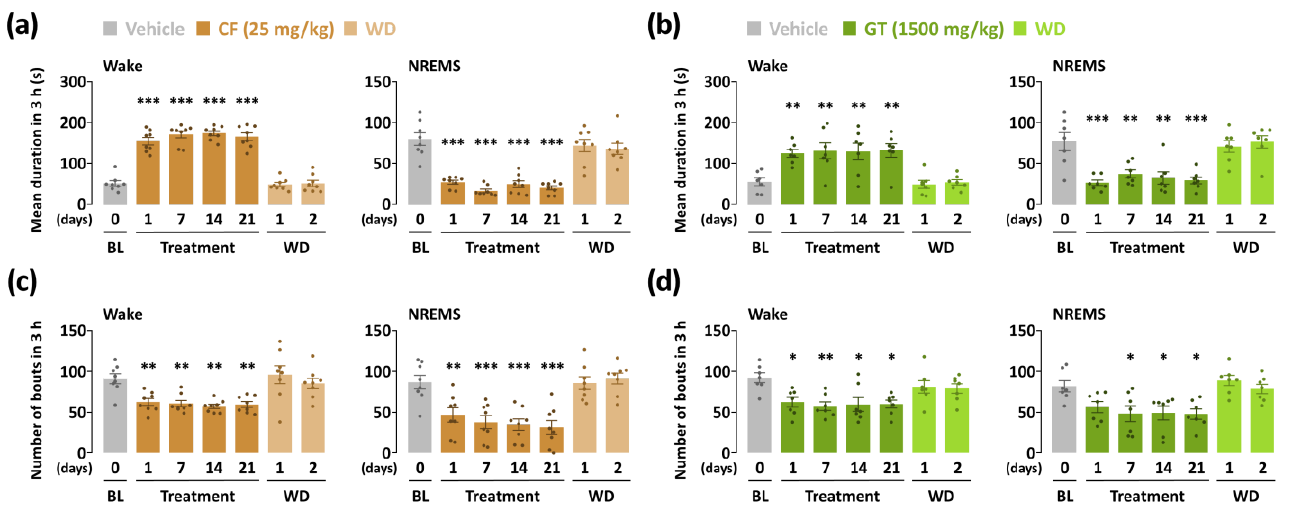
Figure 5. Features of sleep–wake bouts during the 3 h following sample treatment for the chronic administration period (21 days). ( a ) Changes in mean duration of wakefulness and NREMS after caffeine (25 mg/kg) treatment. ( b ) Changes in mean duration of wakefulness and NREMS after GT (1500 mg/kg) treatment. ( c ) The number of bouts of wakefulness and NREMS after caffeine treatment. ( d ) The number of bouts of wakefulness and NREMS after GT treatment. Grey bars illustrate the baseline day (vehicle). Brown and green bars illustrate days when caffeine and GT treatment were administered, respectively. Light brown and green bars illustrate withdrawal (WD) days after caffeine and GT treatments, respectively. Every column denotes the mean ± SEM ( n = 7 – 8). * p < 0.05, ** p < 0.01, and *** p < 0.001, indicate significant differences compared to the vehicle (Dunnett’s test). CF, caffeine; GT, green tea ethanol extract; NREMS, non-rapid-eye-movement sleep; Wake, wakefulness; SEM, standard error of the mean.